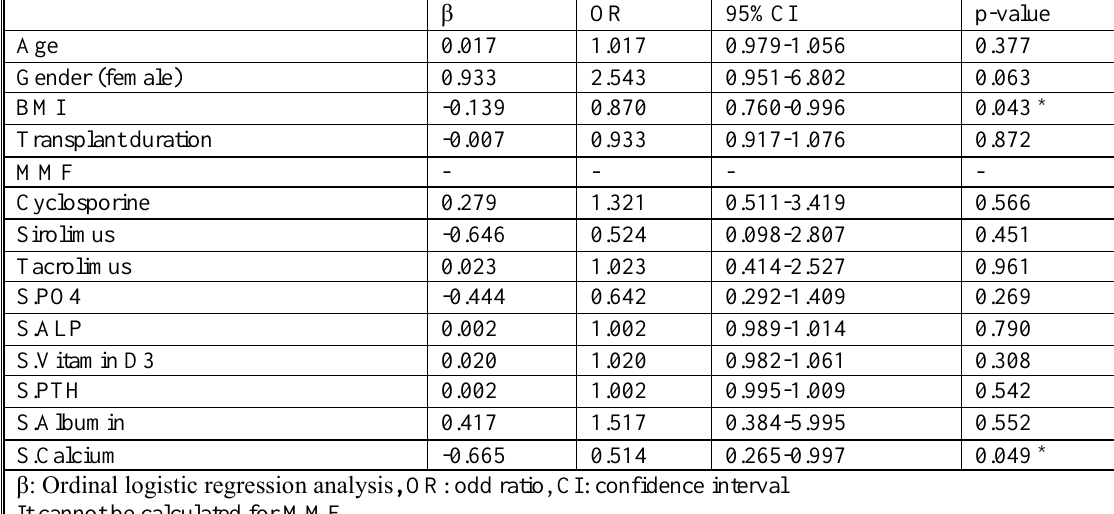
Table 4.Ordinal regression analysis of the predictor of osteoporosis for hip bone in the study group.